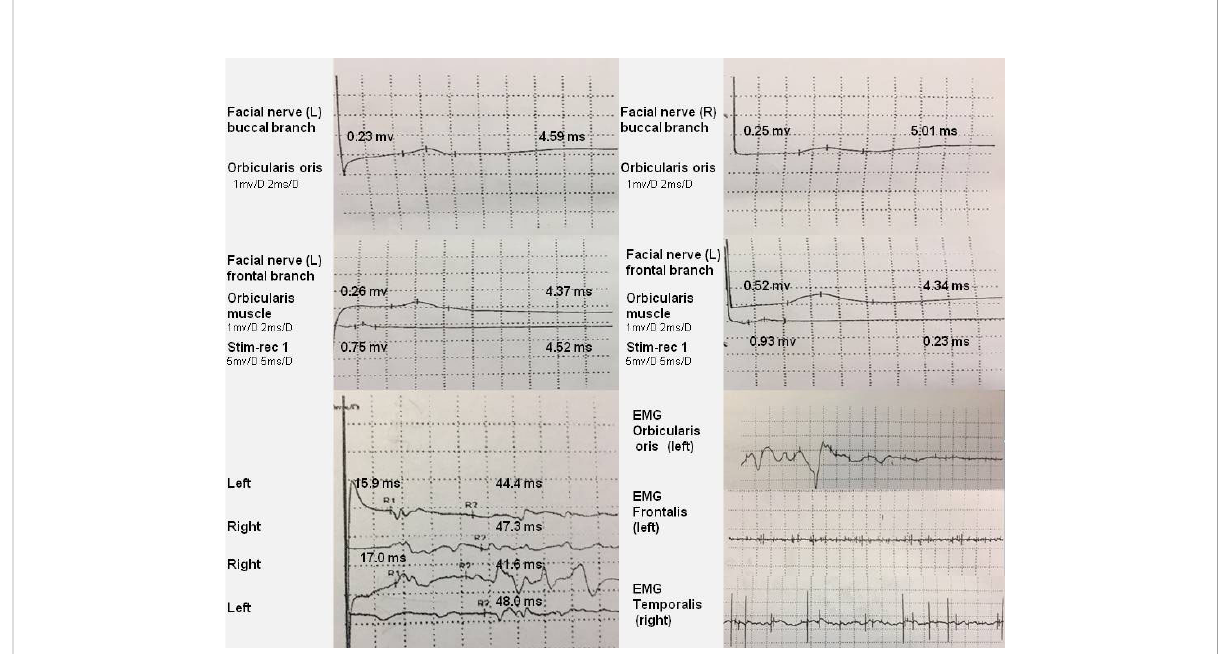
FIGURE 2 EMG reveals that the facial nerve has obvious demyelination and axonal loss. Motor nerve conduction of the bilateral facial nerve (temporal, zygomatic, and buccal branches) is prolonged, and amplitude potentials are decreased. EMG of the bilateral buccinator and orbicularis muscle and the right musculus dormitator show reduced recruitment of motor units with obvious spontaneous activity. Blink re fl ex R1 and R2 latency is prolonged with a discrete